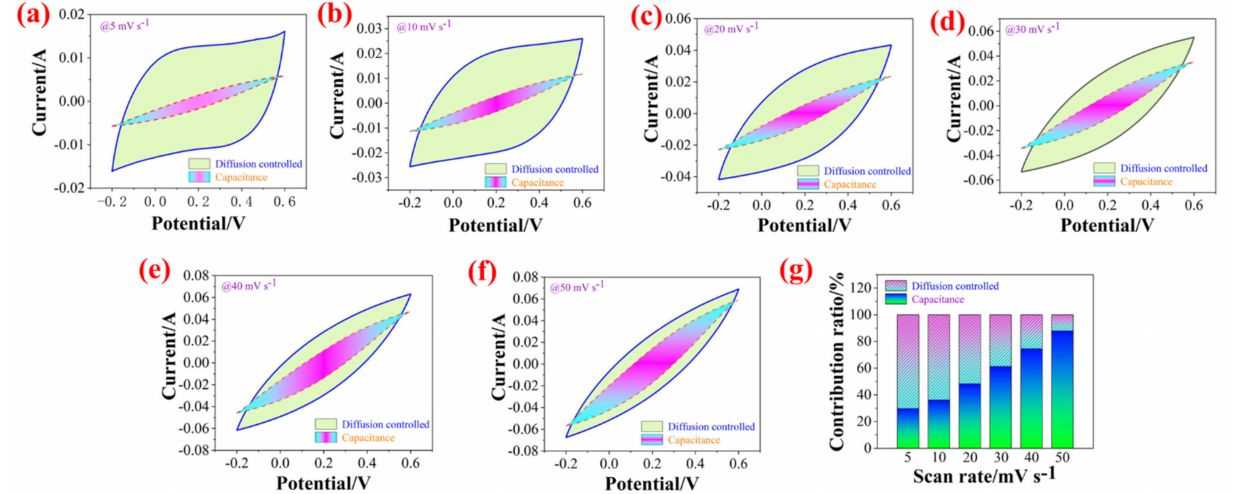
Figure 8. Diffusion controlled and capacitance CV profiles for PZCC-2 electrodes at different scan rates of 5, 10, 20, 30, 40, and 50 mV · s − 1 ( a – f ), and ( g ) contribution ratio of diffusion controlled and capacitance for PZCC-2 electrode material at different scan rates of 5, 10, 20, 30, 40, and 50 mV · s − 1